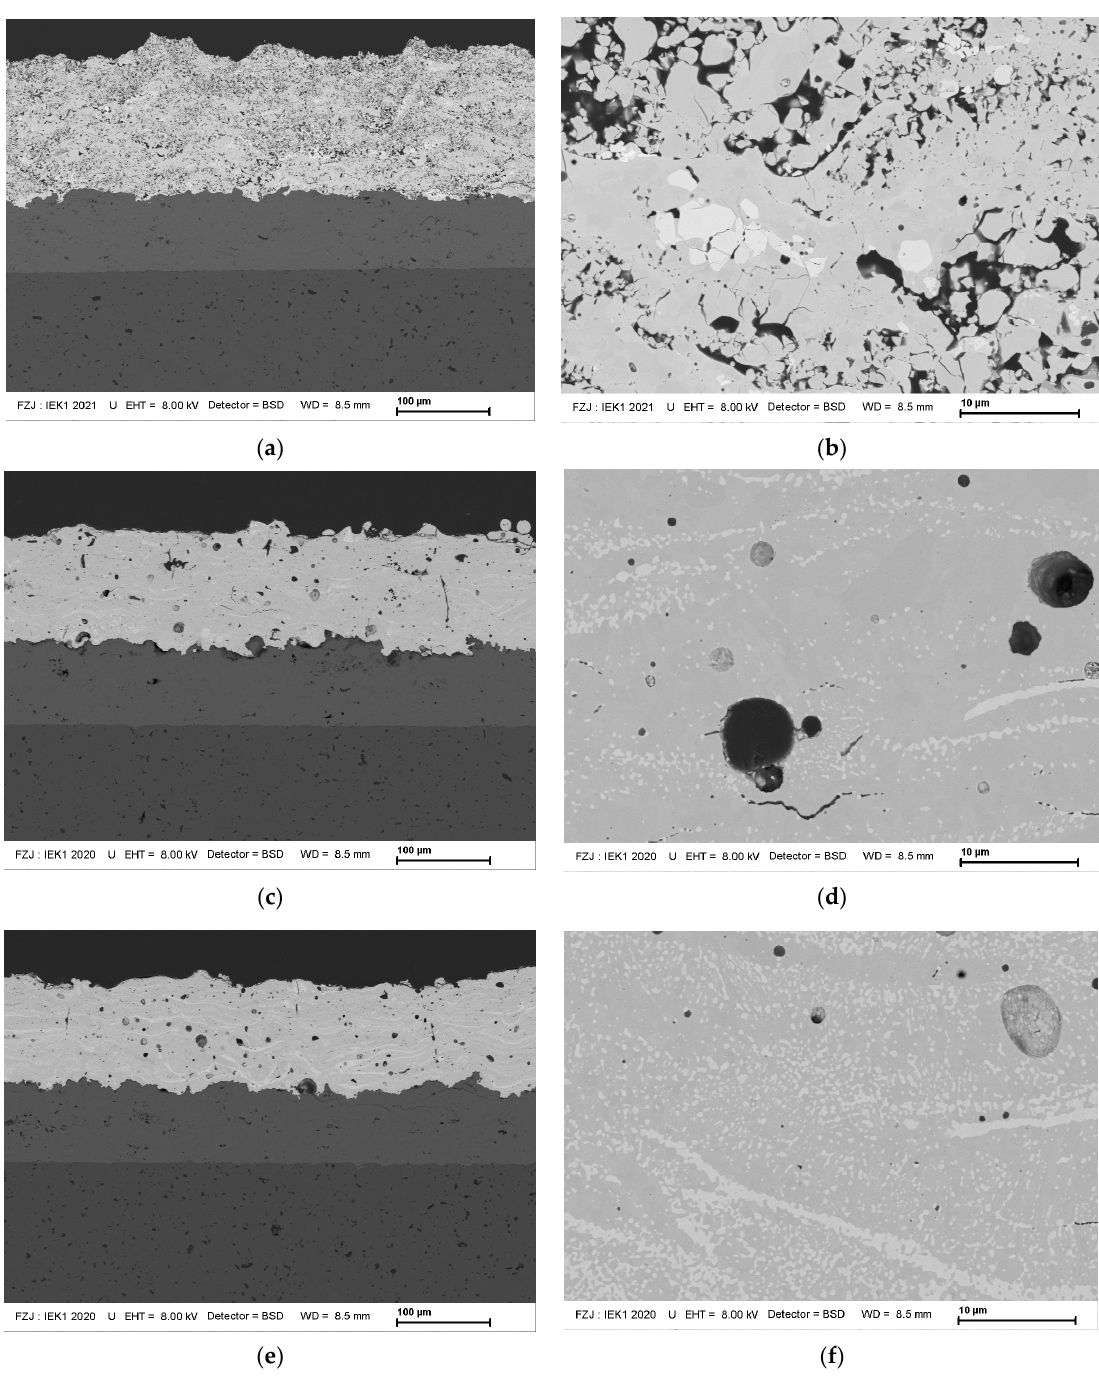
Figure 2. SEM micrographs of the heat-treated YDS coatings (100 h, 1300 °C), ( a , b ) APS1, ( c , d ) APS2, ( e , f ) HV APS1.